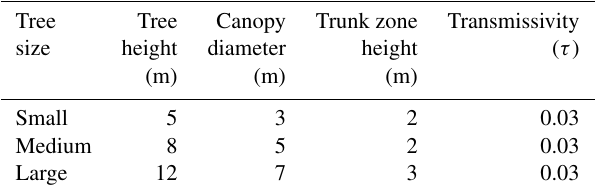
Table 1. Table with different tree sizes used for model evaluation.